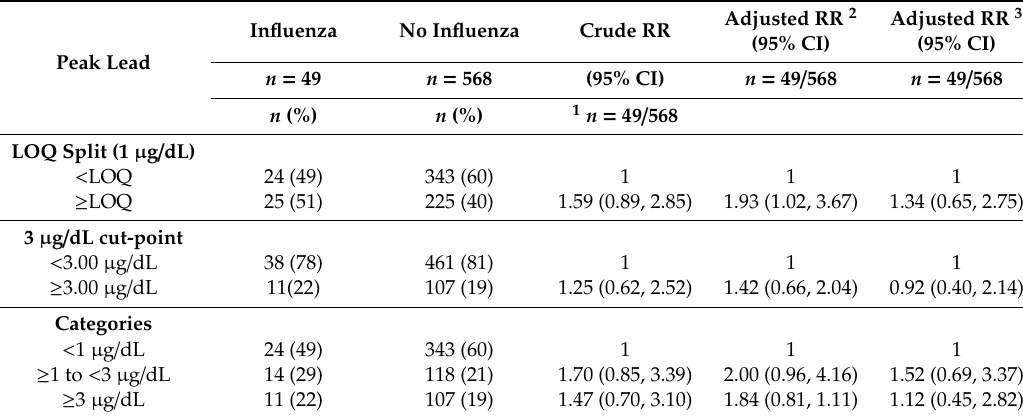
Table 6. Crude and adjusted risk estimates of influenza comparing cases and controls by peak blood lead concentrations in the reduced study sample, while comparing adjustment of ONLY child characteristics and full adjustment of all covariables ( n =